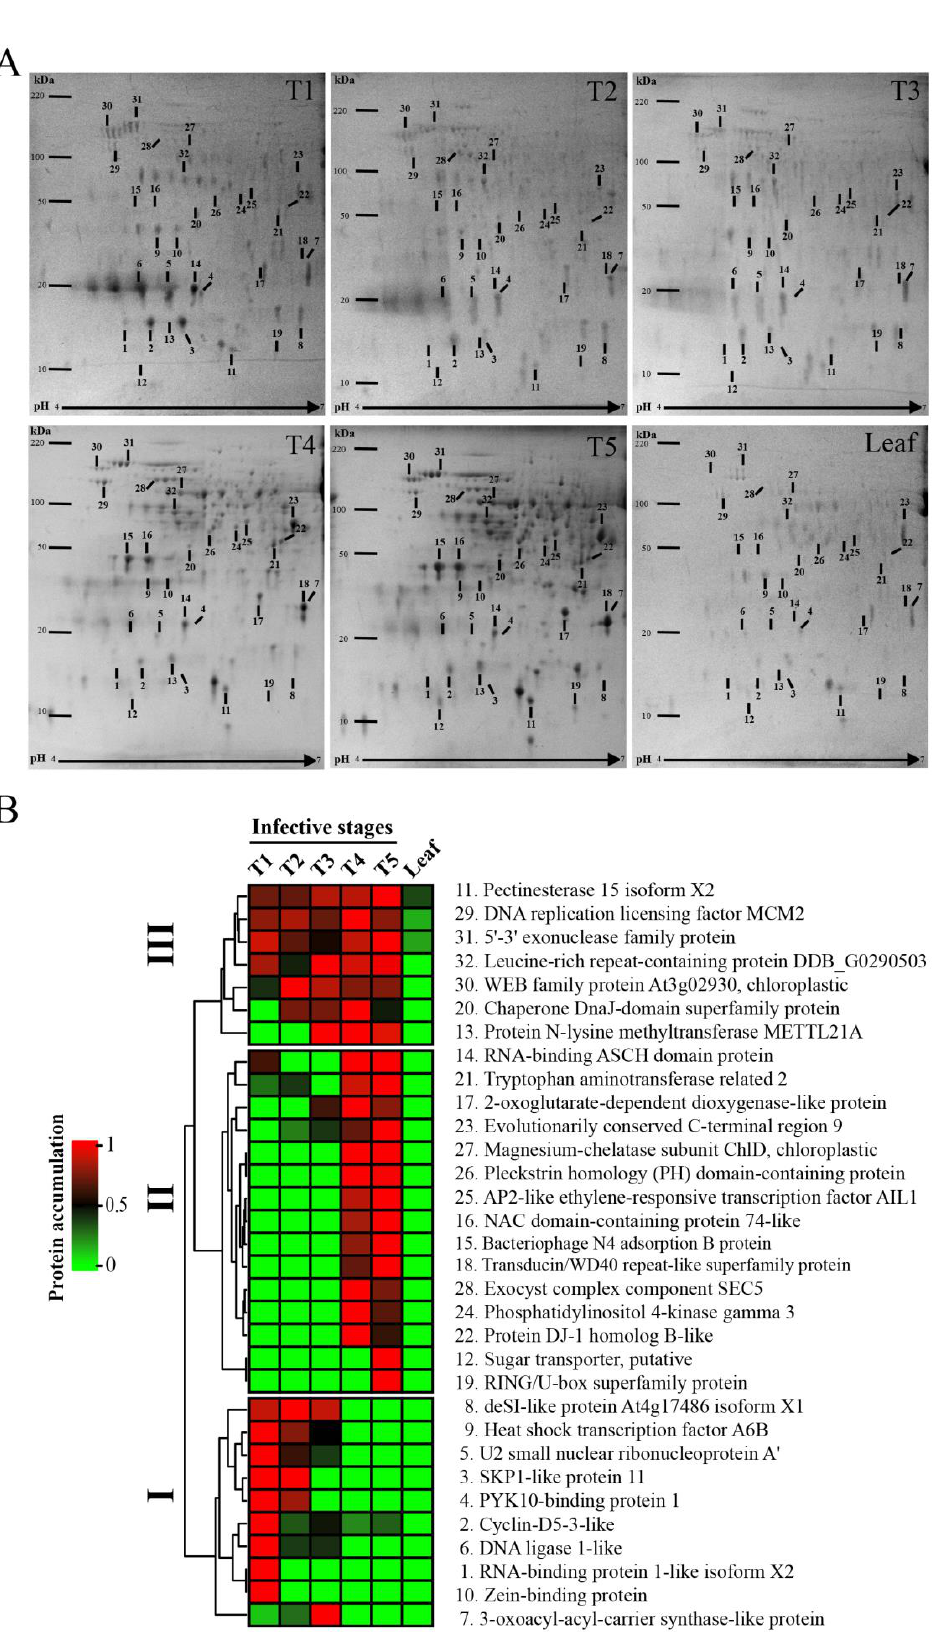
Figure 4. Proteome and heat map analysis of P. calyculatus infective stages. ( A ) Protein profiles and ( B ) heat map cluster analysis of the protein accumulations of the different infective stages (T1–T5) compared with mistletoe